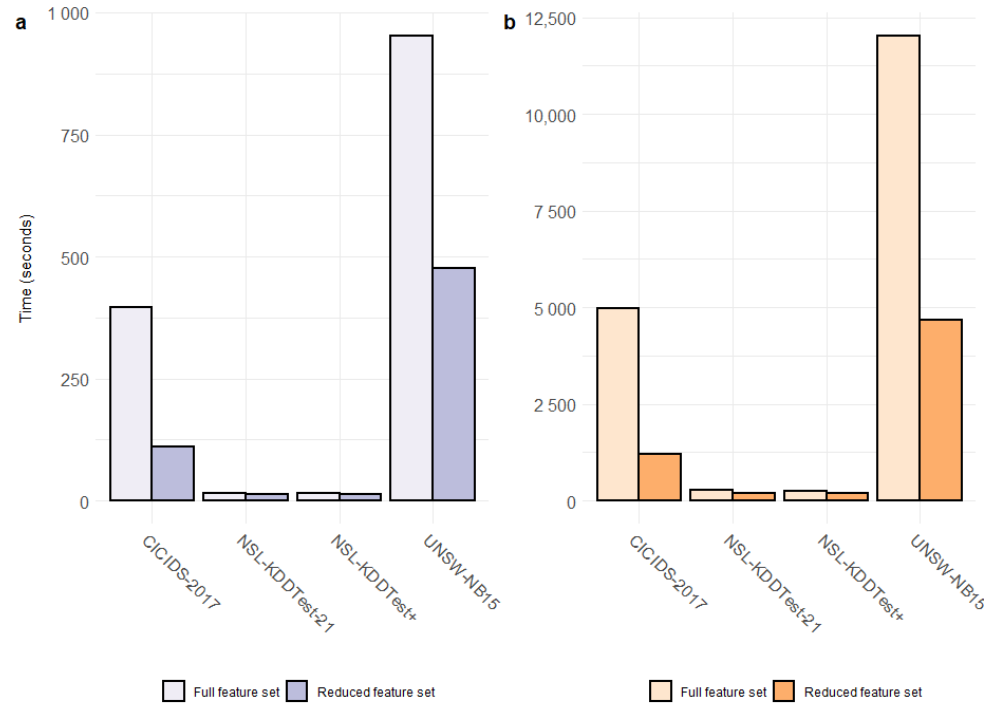
Figure 4. Training and testing complexity for individual GBM ( a ) and GBM-15 ( b ) on reduced and complete feature sets for each data